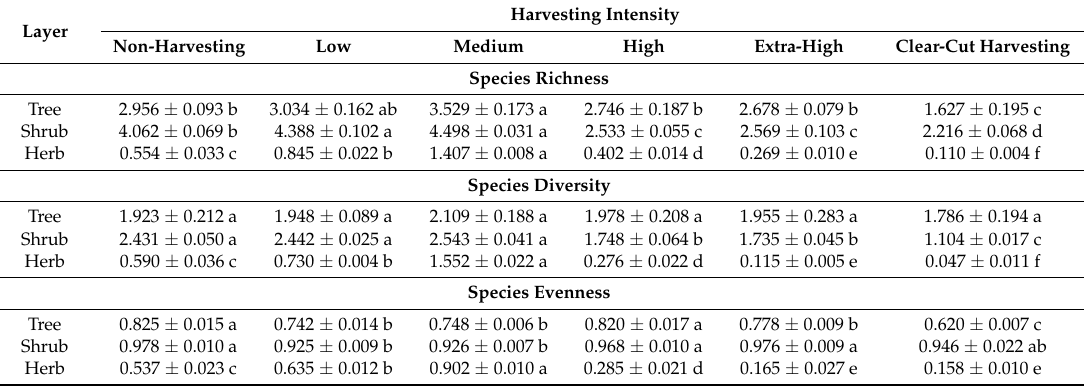
Table 4. Results of multiple comparisons of diversity indices of various layers 15 years after harvesting. Layer